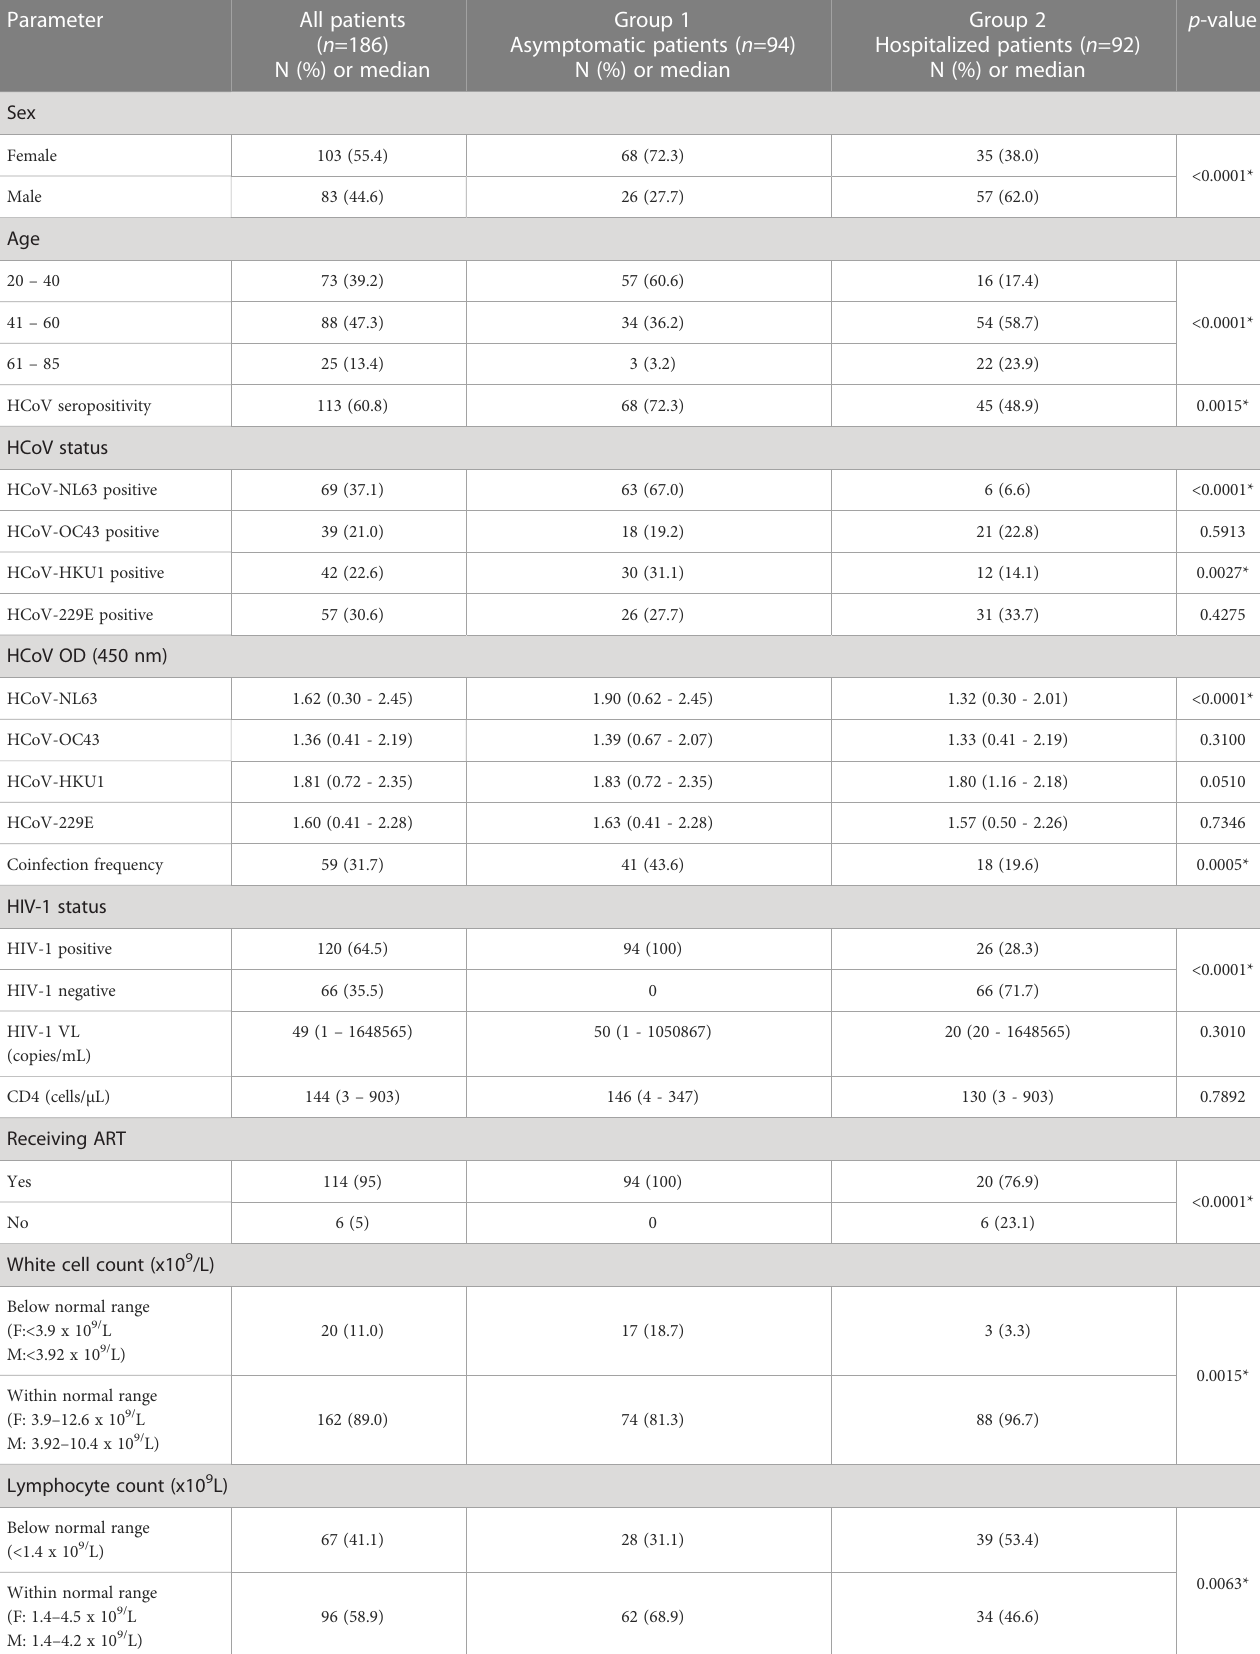
TABLE 1 Baseline demographic and clinical characteristics of the two patient groups (n = 186) according to COVID-19 severity (group 1: asymptomatic with positive SARS-CoV-2 serology, n = 94; group 2: hospitalized COVID-19 patients, n = 92).